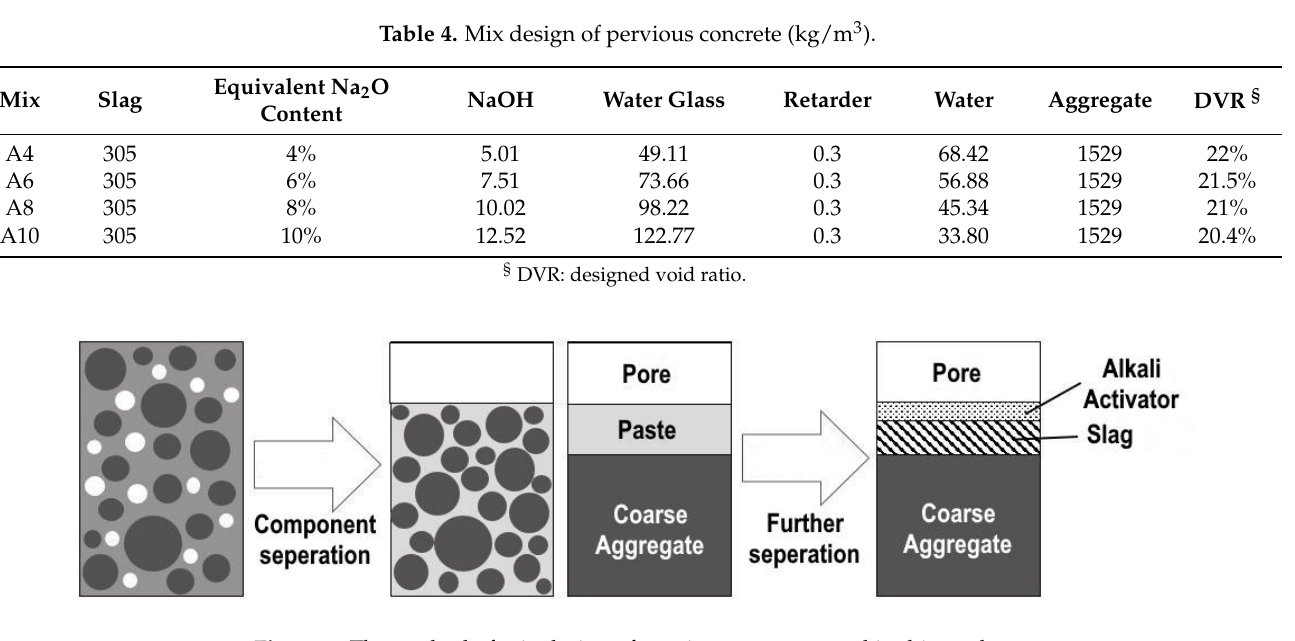
Figure 3. The method of mix design of pervious concrete used in this study.